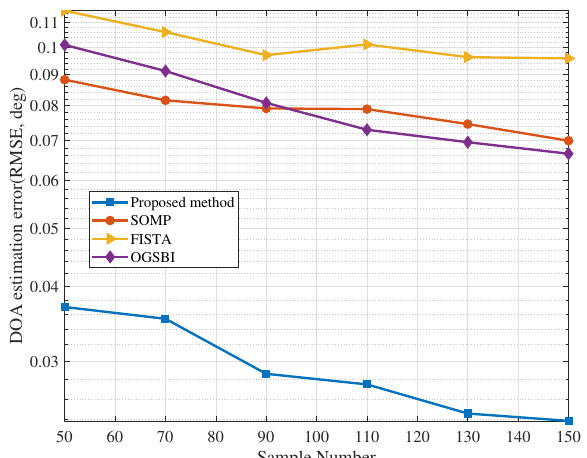
Figure 4. DOA estimation performance with different numbers of samples.